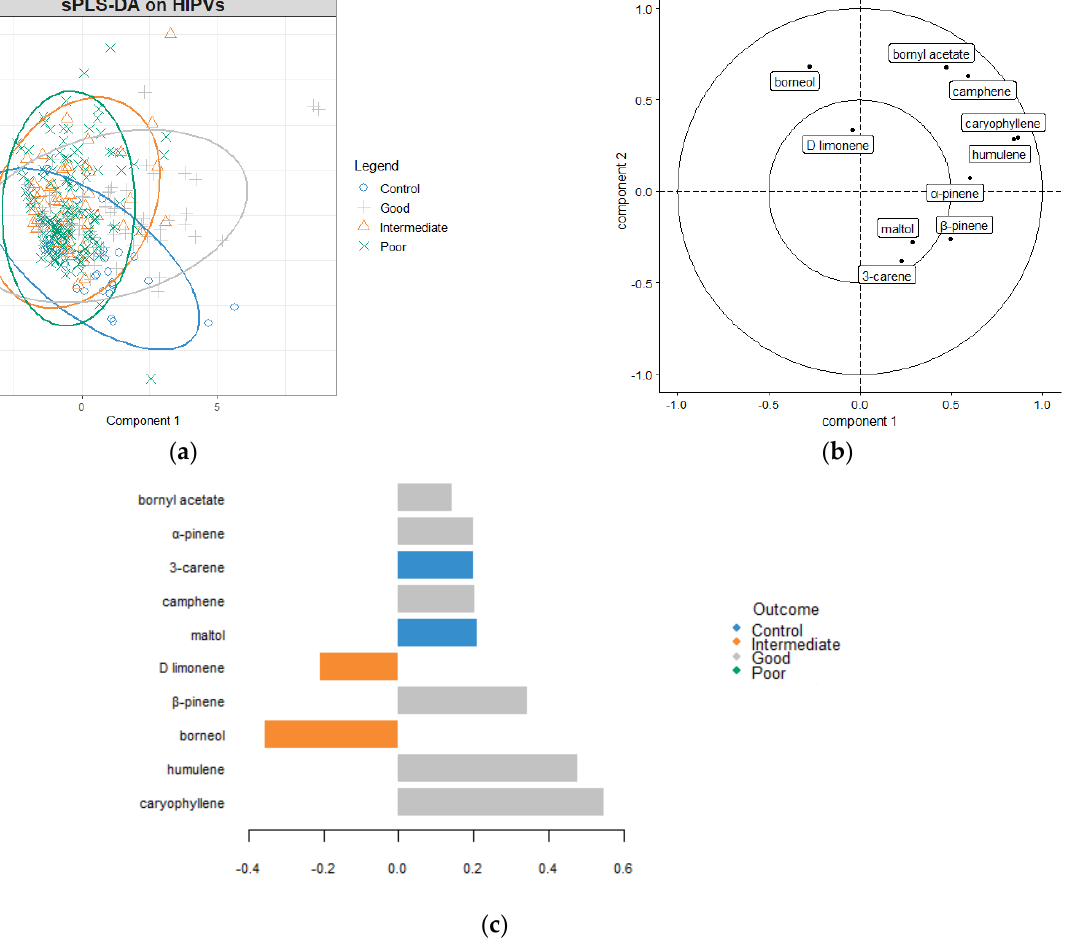
Figure 1. Sample chromatogram of fir foliar extract. Peak assignments are as follows: (1) α -pinene,